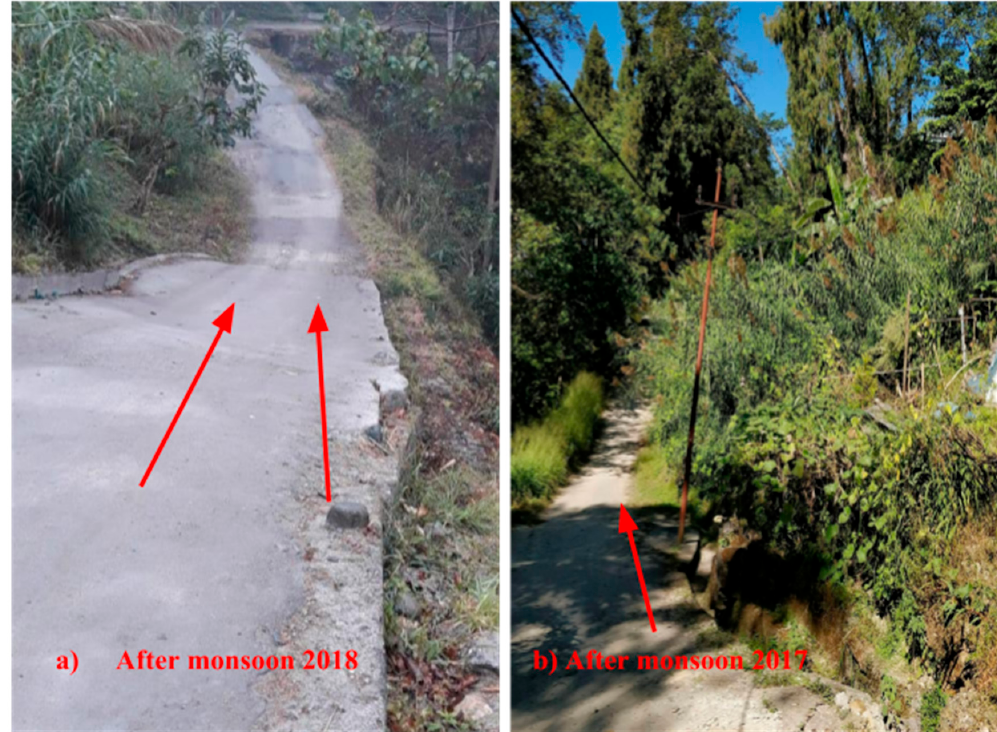
Figure 11. Displacements observed after 2018 and 2017 monsoons near sensor 2 ( a ) after the 2018 monsoon and ( b ) after the 2017 monsoon.